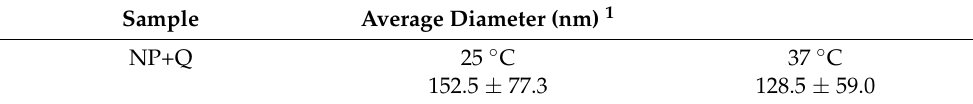
Figure 4. 1 H NMR spectrum (400 MHz, D 2 O, 298 K) of PCL-PEG-PCL micelles loaded with querce- tin.